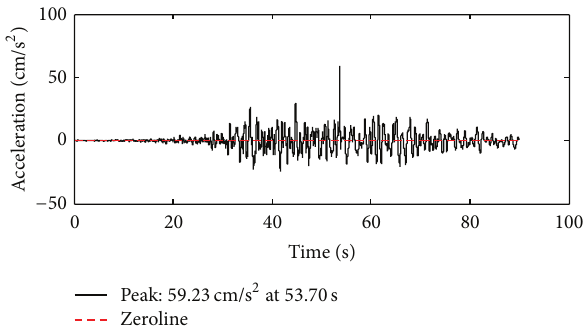
Figure 5: Acceleration time history (KAU022 N.SAC, ratl = 4.48, ratr =